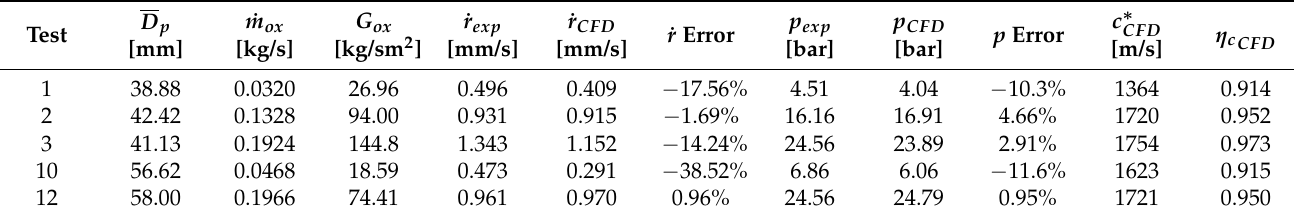
Table 7. Numerical results of GOX-HTPB motor tests.